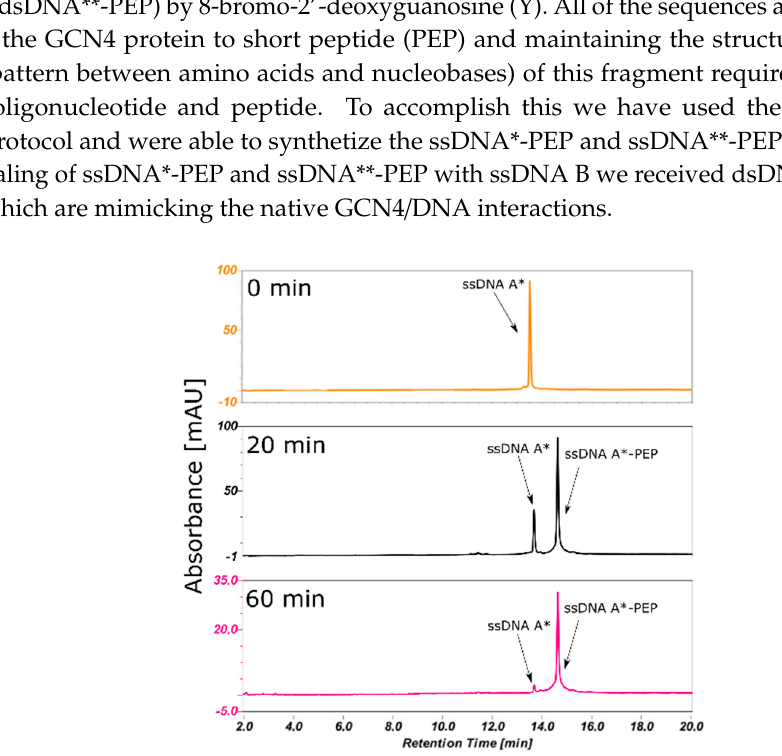
Figure 2. Progression if the click chemistry reaction monitored by high-performance liquid chromatography (HPLC), after 20 (black) and 60 (pink) mins. ssDNA (A*) standard before the reaction is shown in orange. After 60 min all of the substrate (ssDNA A*) was transformed into product (ssDNA A*-PEP). Injection volumes was as follows: 10 µL, 10 µL and 5 µL respectively for 0, 20 and 60 min. HPLC conditions: XBridge OST reverse-phase C18 column; mobile phases A: 50 mM triethylamine acetate (TEAA) and 1% acetonitrile in water, B: 80% ACN in water; a gradient of 0–20%/20 min B was used, maintaining 1 mL/min flow rate; recorded at 260 nm.